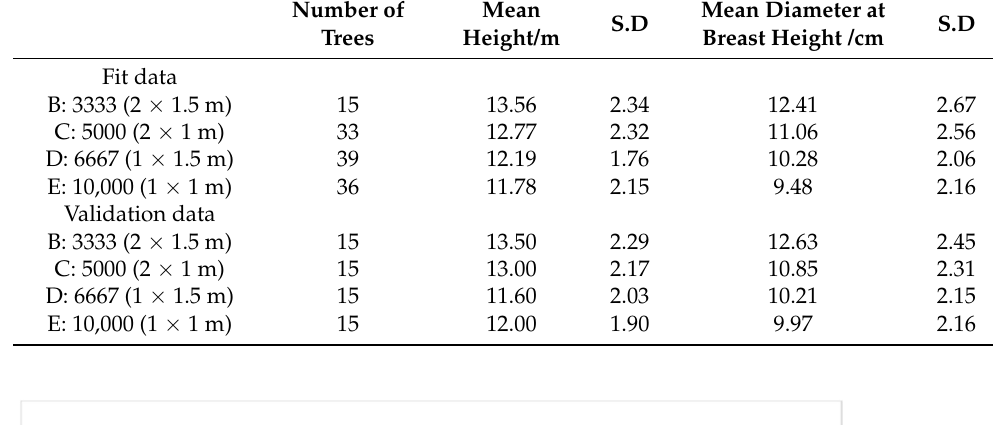
Table 1. Summary statistics for fit data and validation data of density test stand of Chinese fir.